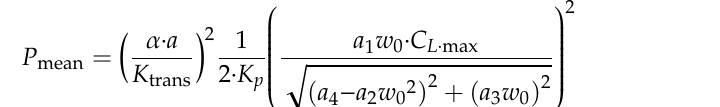
Table 1. Model parameters.